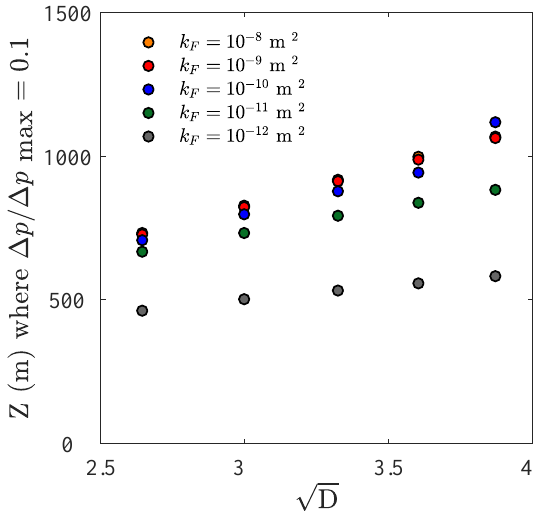
Figure 5. Effects of pore pressure diffusicity. Here we plot the depth at which arrives the 10% of the maximum surface pressure for several values of the fault permeability and fault diffusion coefficient. The fault permeability ranges from 10 − 8 to 10 − 12 m 2 , while the diffusion coefficient varies between 7 and 15. We represent the results with regard to the square root of D . Table 1 lists the parameters of the